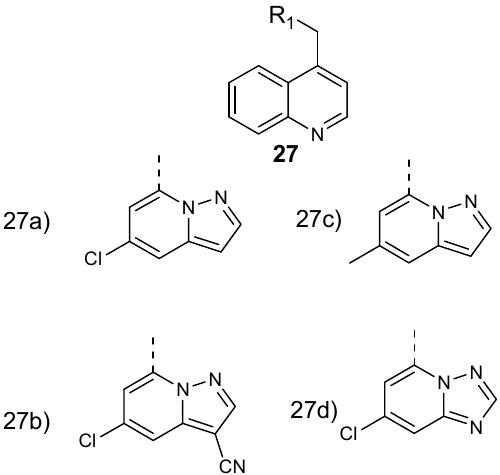
Figure 11. Structure of 8-aminoquinoline–pyrazolopyrimidine hybrid compounds 27a –